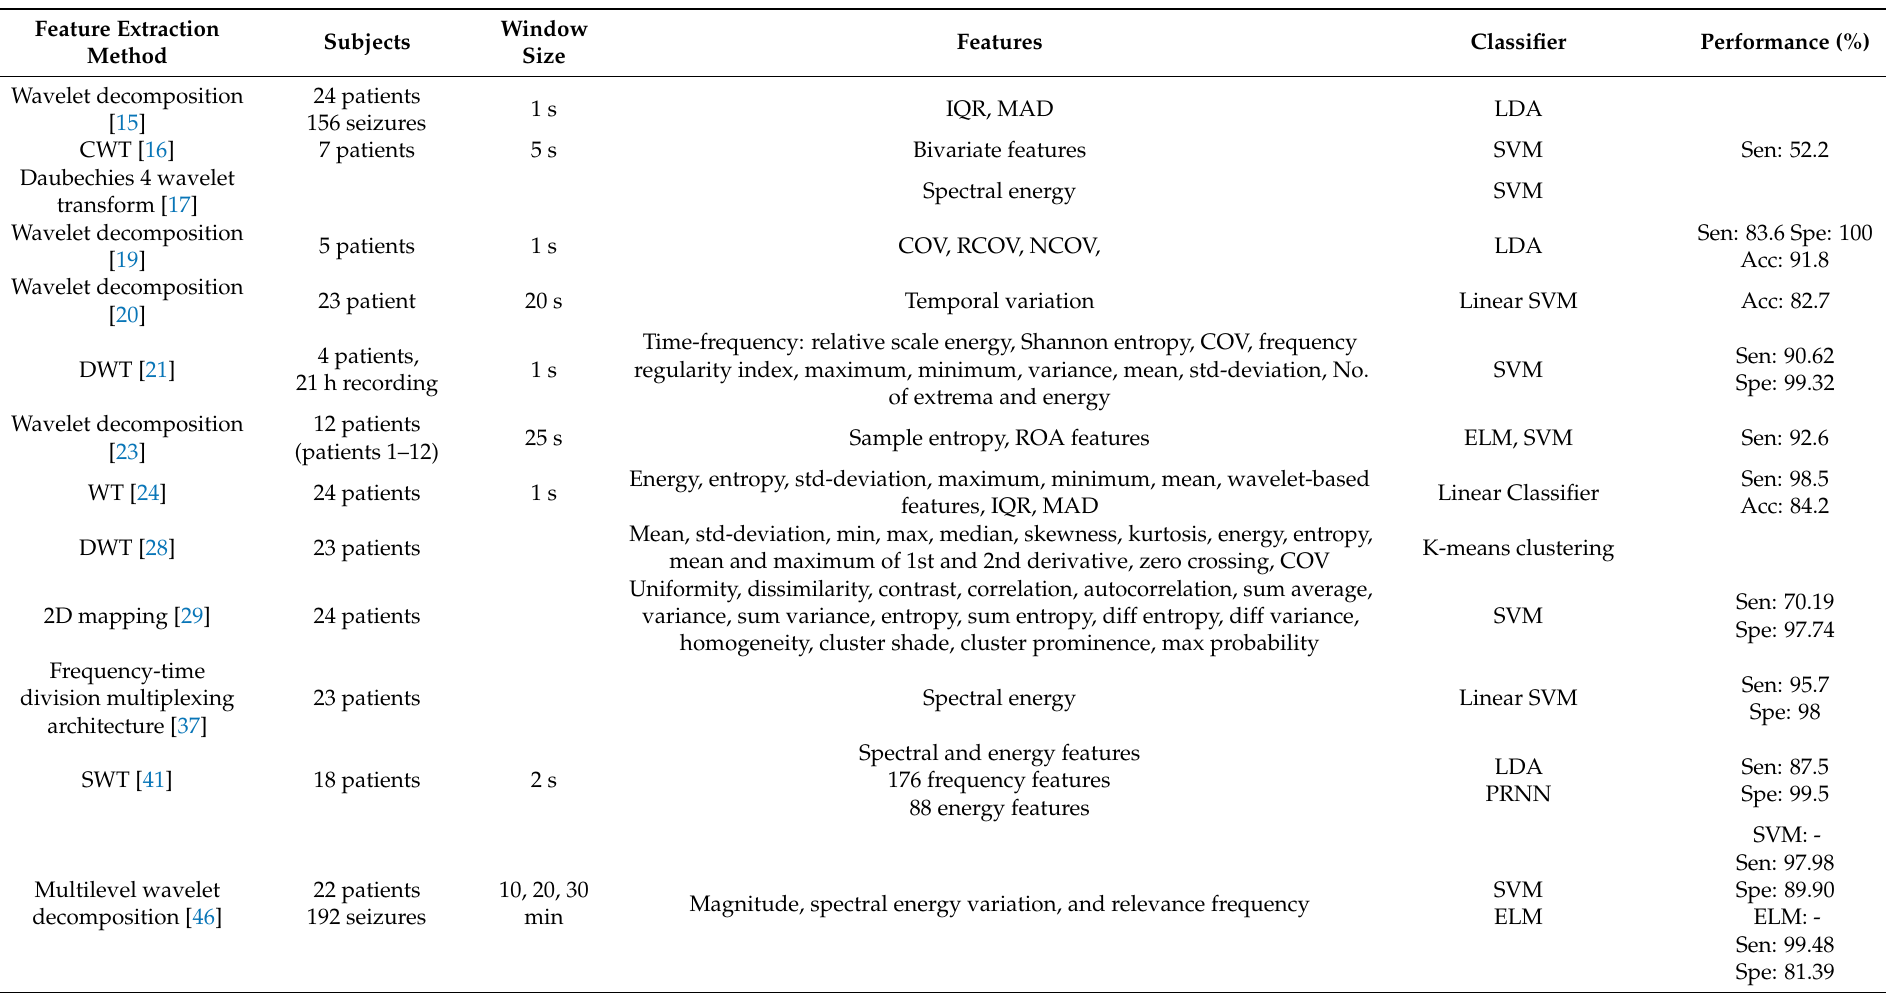
Table 3. Summary of epileptic seizure detection approaches in the time-frequency